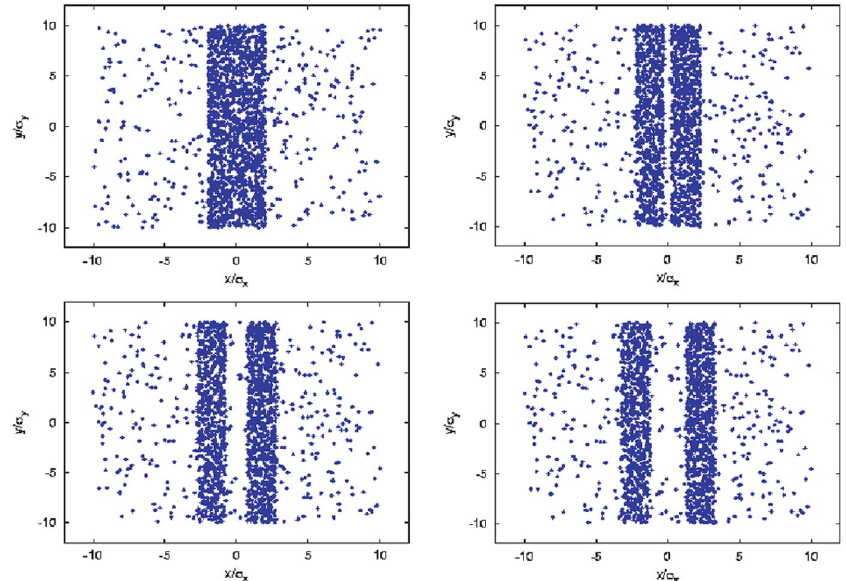
FIG. 72. (Color) Illustration of electron distributions with one or two vertical stripes, representing initial electron densities which may exist in a dipole field; here 10% of the electrons are distributed uniformly, 90% are in the stripes; as shown in Fig. 73, the different stripe distributions yield different wakefields for the same average density [91].